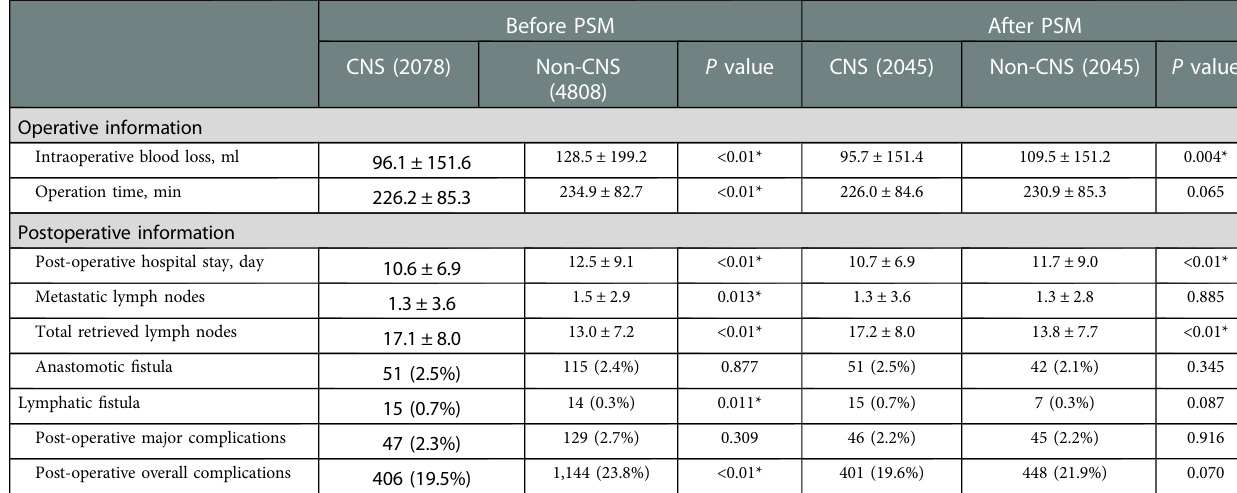
TABLE 3 Outcomes before and after